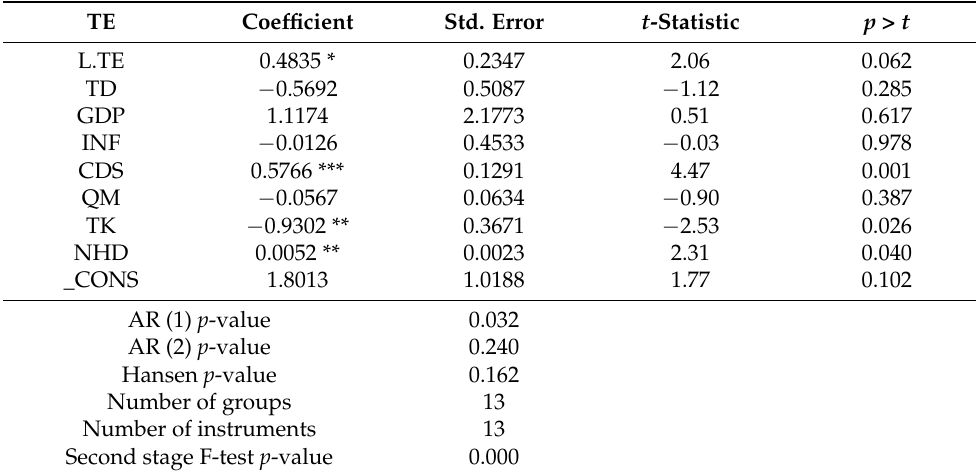
Table 3. The Estimation result of Model